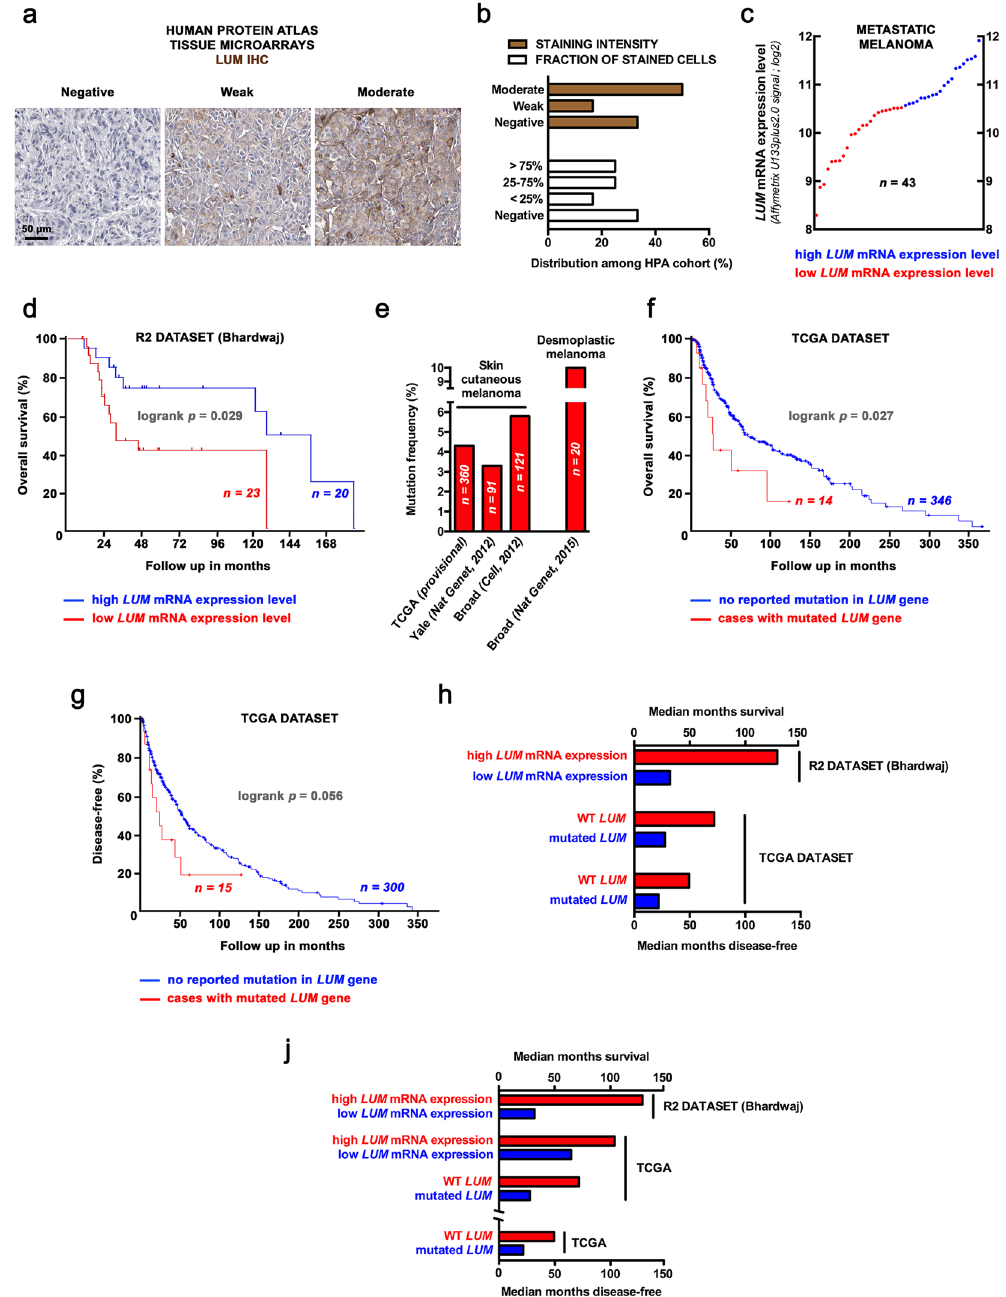
Figure 1. Correlation of lumican expression and outcome in melanoma patients: a comprehensive mining of available clinical databases. ( a ) Microphotographs of lumican (LUM) IHC in tissue microarrays from the Human Protein Atlas cohort (available from www.proteinatlas.org). Anti-LUM pAb (HPA001522, Sigma- Aldrich) has been used at a 1:150 dilution for IHC staining of tissues, followed by hematoxylin counter- coloration to enable visualization of microscopic features. ( b ) Distribution of melanoma cases among 3 levels of LUM staining intensity ( brown ) and fraction of cells stained for LUM expression ( white ). ( c ) Analysis of LUM mRNA expression levels (log2; Affymetrix U133plus2.0 signal) in microarray data for metastatic melanoma 26 . The log2 signal background for this probe (201744_s_at) is 6.37. Red and blue circles respectively stand for low and high LUM mRNA expression in 2 groups designed for further survival analysis. ( d ) Kaplan-Meier analysis for overall survival rates of 44 melanoma patients grouped by LUM mRNA expression. Logrank test raw p value is indicated. ( e ) Box-plot shows LUM expression across risk groups from TCGA dataset (SurvExpress tool), including the p value testing for difference using t test. Heat map displays LUM expression in risk groups, with low expression being represented in green grades and high expression in red grades. Calculated β coefficient from the Cox fitting (i.e. linear relationship between gene expression and prognostic index) was − 0.121 for LUM gene. ( f ) Overall survival Kaplan-Meier plot for high ( blue ) and low ( red ) LUM -expressing risk groups is shown, with logrank p value being indicated. ( g ) Frequency of LUM somatic mutation among clinical